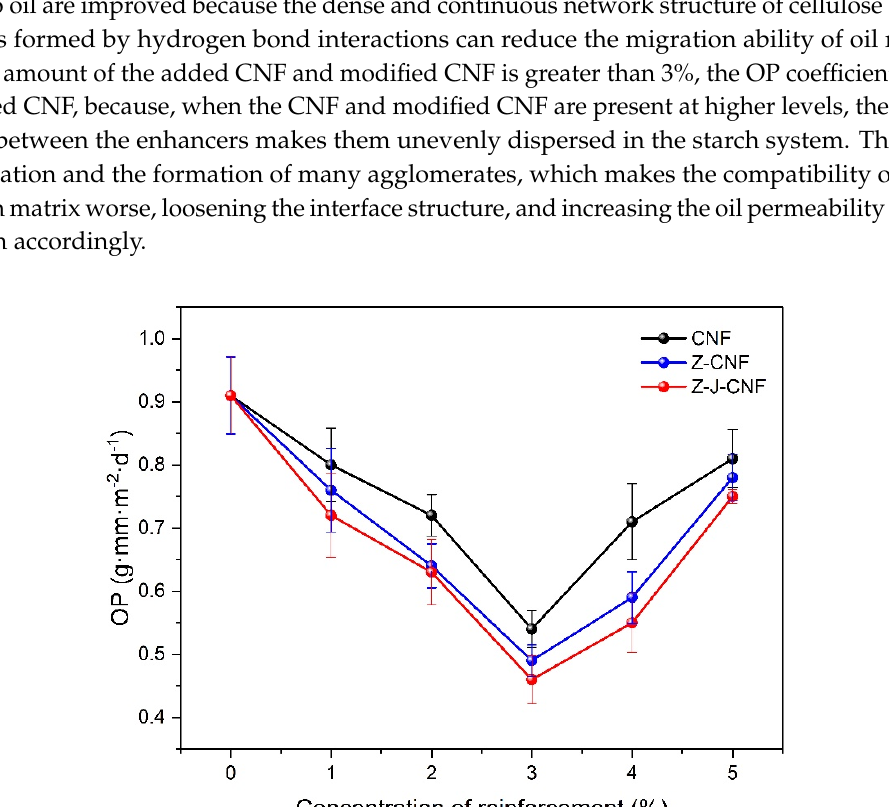
Figure 11. Effects of CNF, Z-CNF, and Z-J-CNF content on water absorption of the films.